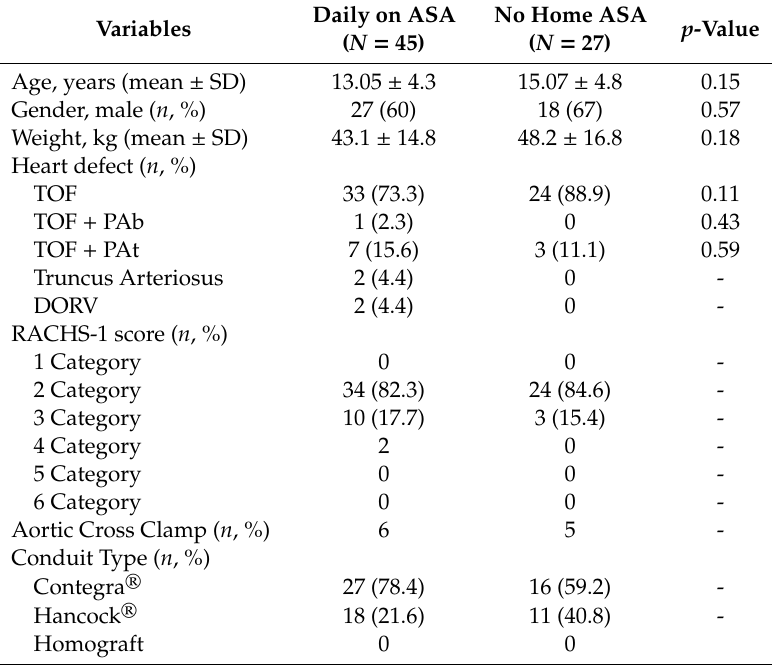
Table 1. Baseline sociodemographic and clinical pre-matching characteristics. Variables